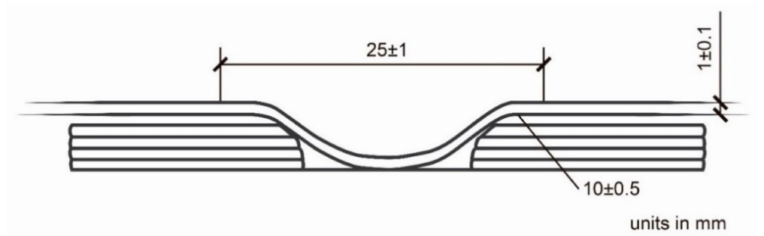
Figure 2. Straight section of the proposed